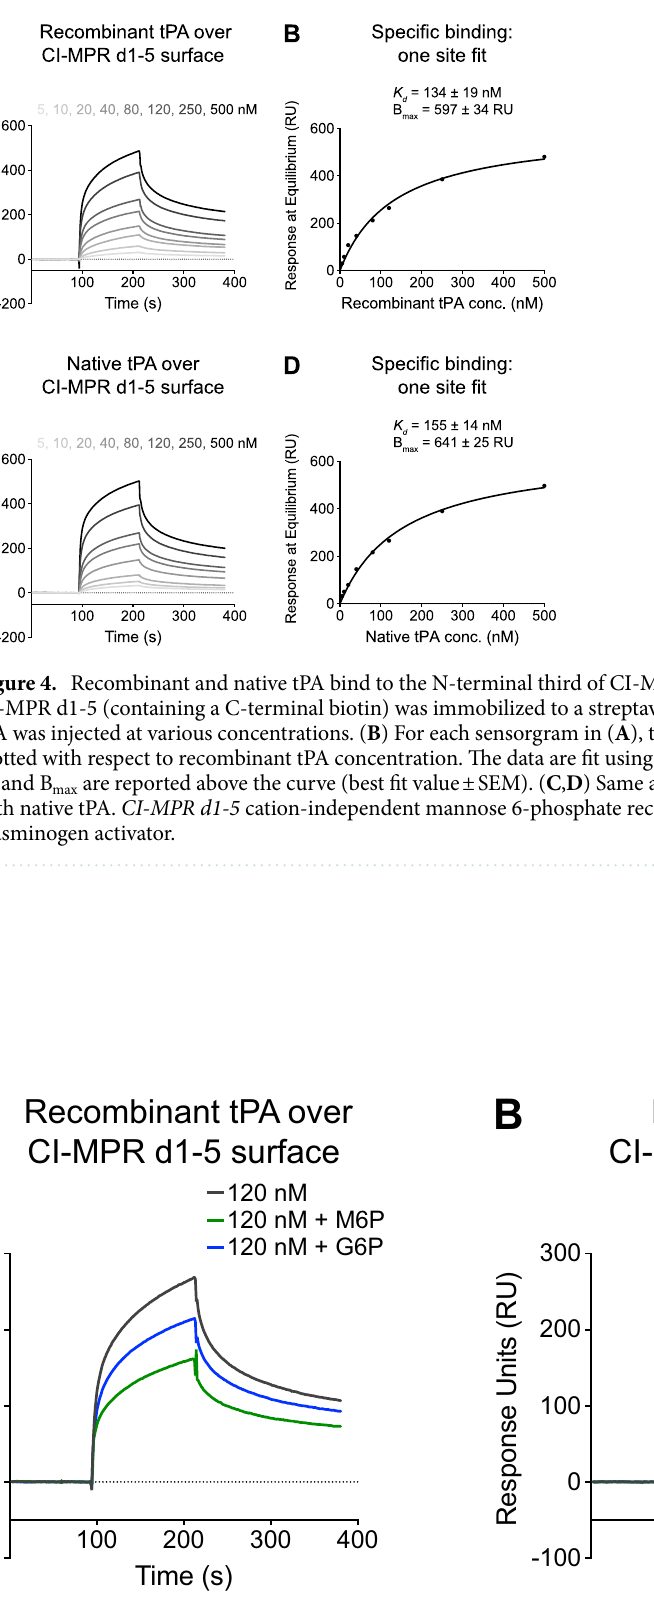
Figure 5. tPA binding to immobilized CI-MPR d1-5 is partially inhibited by M6P. ( A ) C-terminal biotinylated human CI-MPR d1-5 was immobilized to a streptavidin sensor chip, and recombinant tPA was injected at 120 nM in the presence of 5 mM M6P or 5 mM G6P. The resulting sensorgrams are shown. ( B ) Same as in ( A ), but with native tPA. CI-MPR d1-5 cation-independent mannose 6-phosphate receptor domains 1–5, tPA tissue plasminogen activator, M6P mannose 6-phosphate, G6P glucose